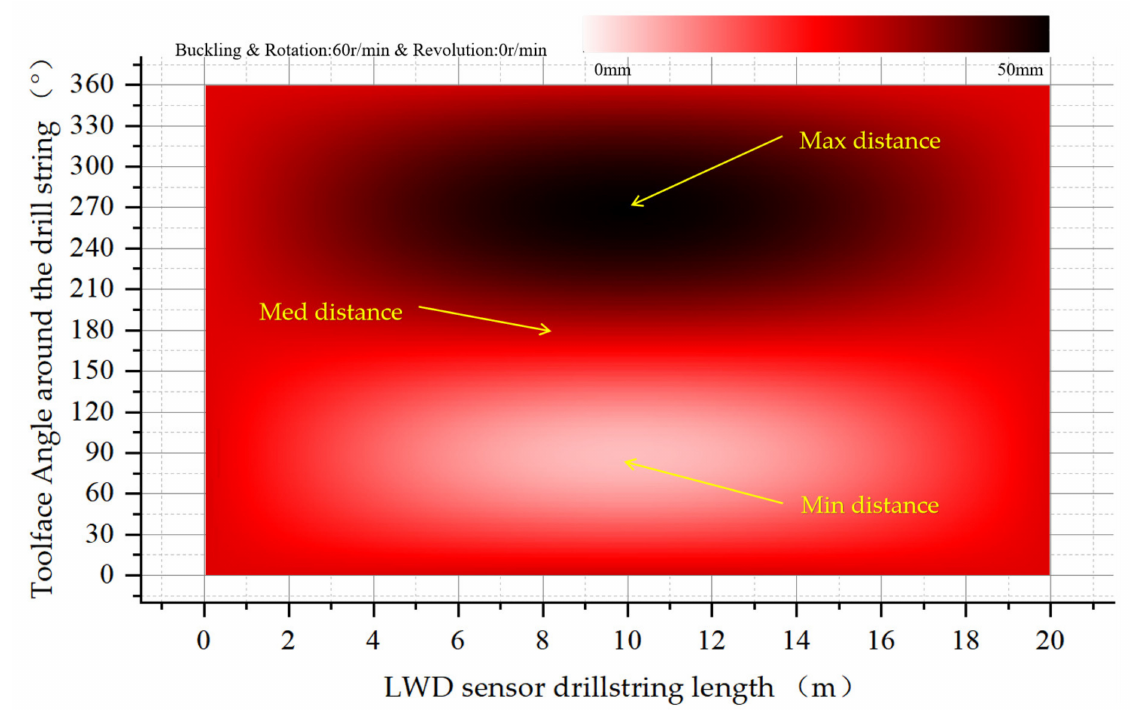
Figure 15. Eccentricity distribution of drill collars during buckling rotation (no revolution) in